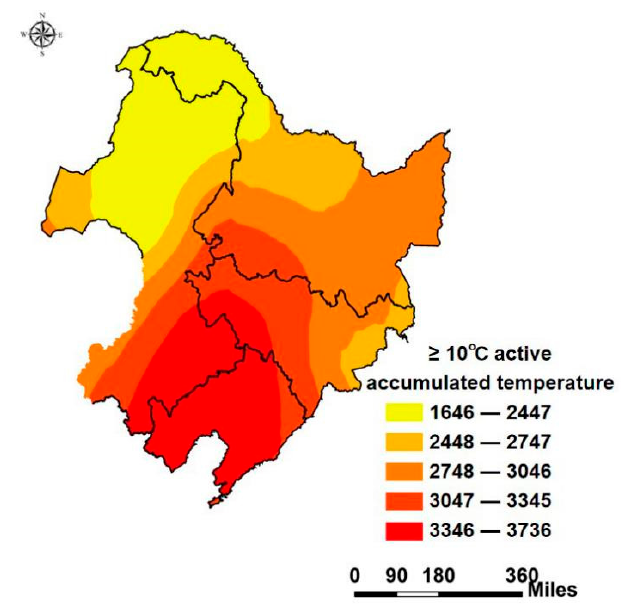
Figure 4. Distribution of annual AAT in Northeast China.